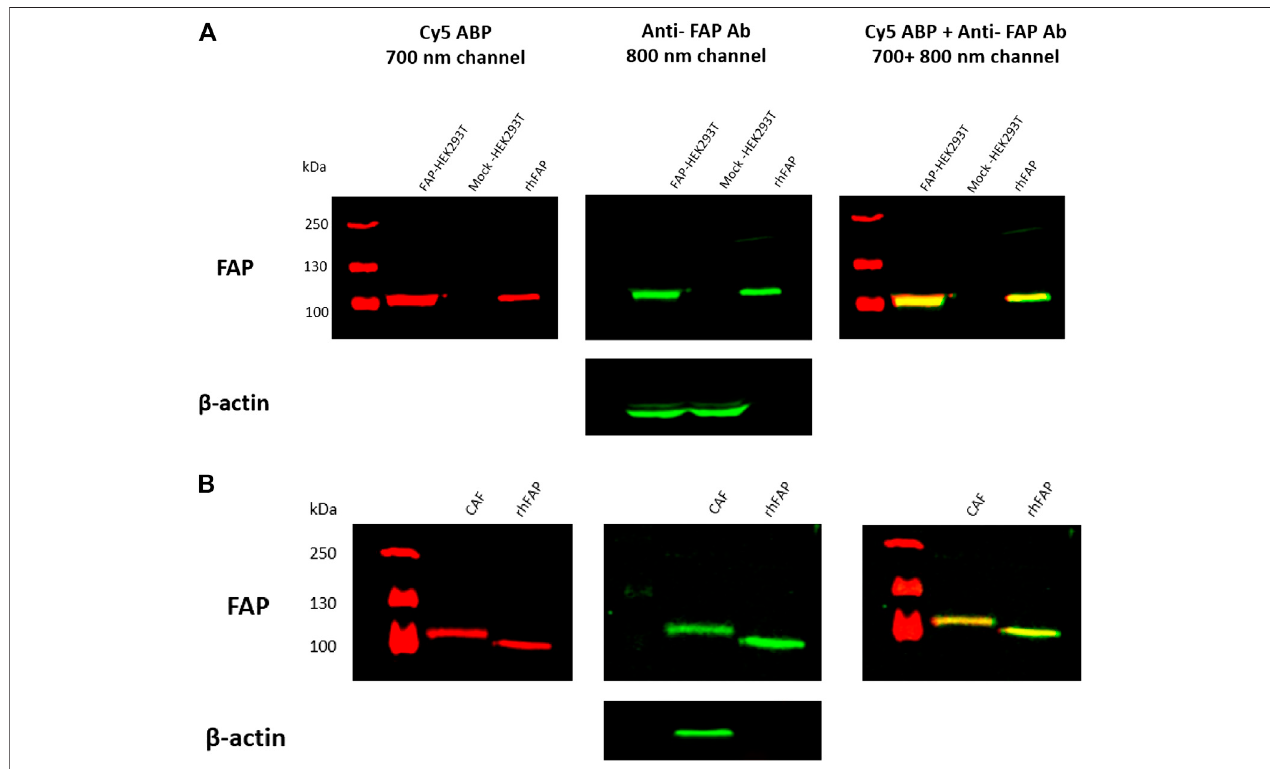
FIGURE 3 | FAP labeling in FAP-transfected HEK293T (A) and TGF- β 1-stimulated CAF cells (B) using compound 7 (Cy5-labeled probe). Cell lysates were incubated with 200 nM of 7 (Cy5 probe) for 30 min at 37 ° C, followed by SDS-PAGE and western blot analysis. The red bands (700 nm channel) correspond to FAP labeling with the Cy5 probe, whereas the green bands (800 nm channel) correspond to FAP labeling with a selective anti-FAP antibody. β -Actin was used as loading controlforFAP-and mock-transfectedHEK293Tcells. In-housepuri fi edrhFAPwasloadedaspositivecontrol.TheCy5probeisselectivetowardsFAPinboth the HEK293T (A) and CAF cell lines (B) , as con fi rmed by co-labeling of the Cy5 probe (red) with the anti-FAP antibody